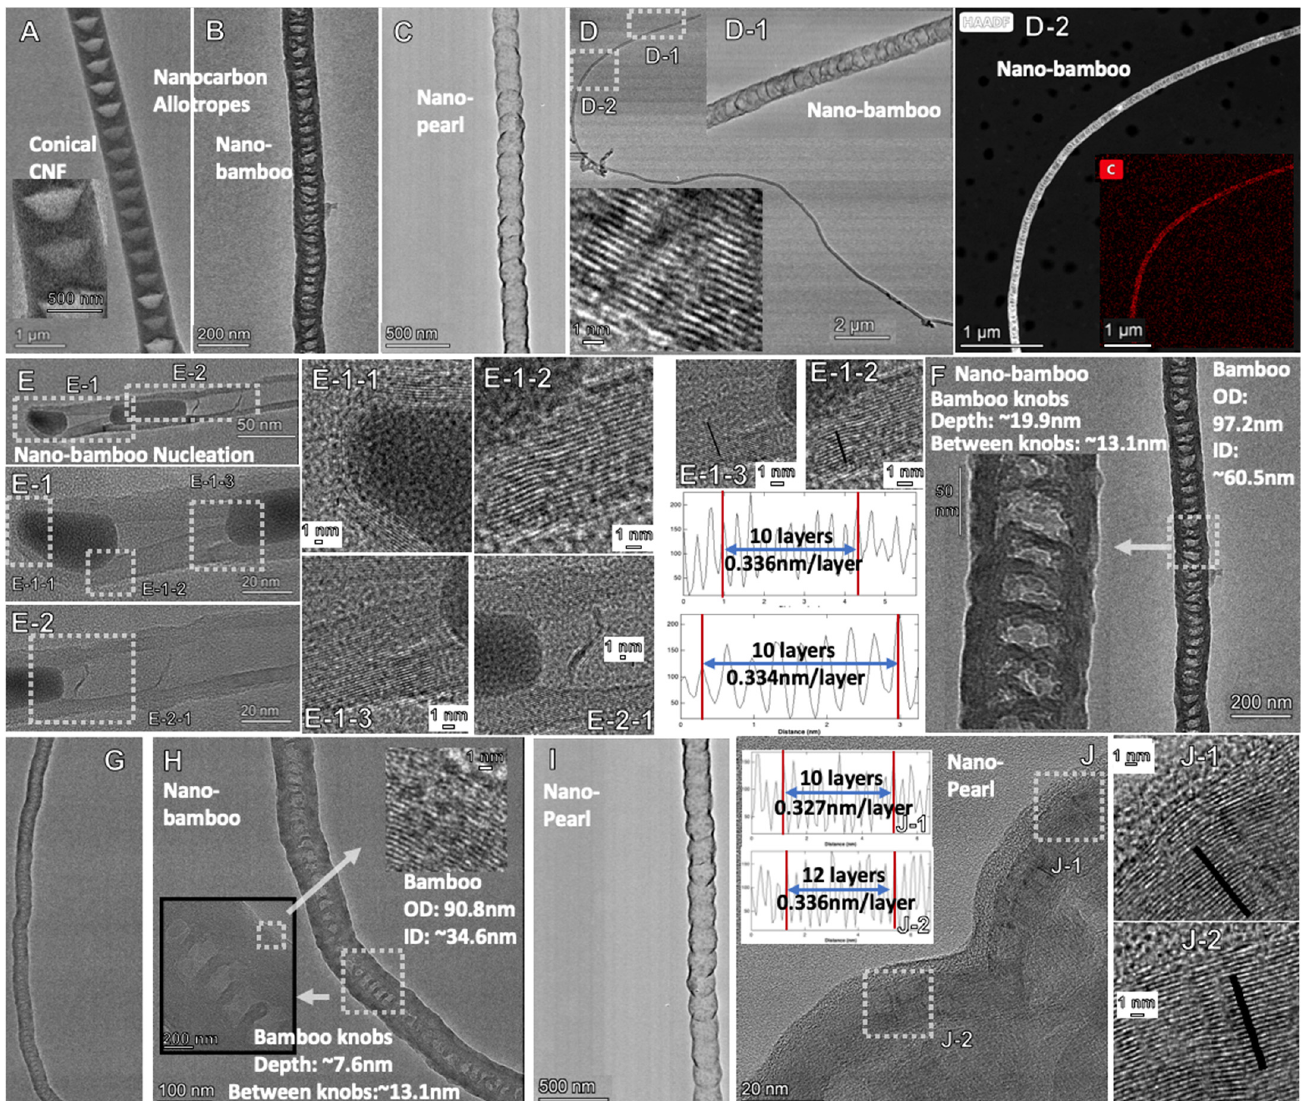
Figure 3. TEM of new molten carbonate synthesized carbon allotropes: Comparison of nano-bamboo, nano-pearl and conical CNF. ( A ): CNF; ( B ): Nano-bambpo; ( C ): Nano-pearl; ( D ), D-1, D-2 Nanobamboo; ( E ), E-1, E-2, E-1-1; E1-2 & E1-3 Nano-bamboo including measured graphene layer thickness; ( F , G , H ) Nano-bamboo knobs, ( I ):, ( J ) Nano-pearl; J-1, J-2 Nano-pearl with measured graphene layer thickness.